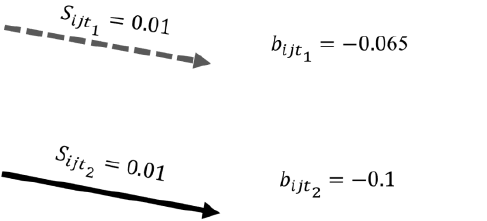
Figure 2. Example of the calculation of 𝑏 𝑖𝑗𝑡 with Criterion 1.